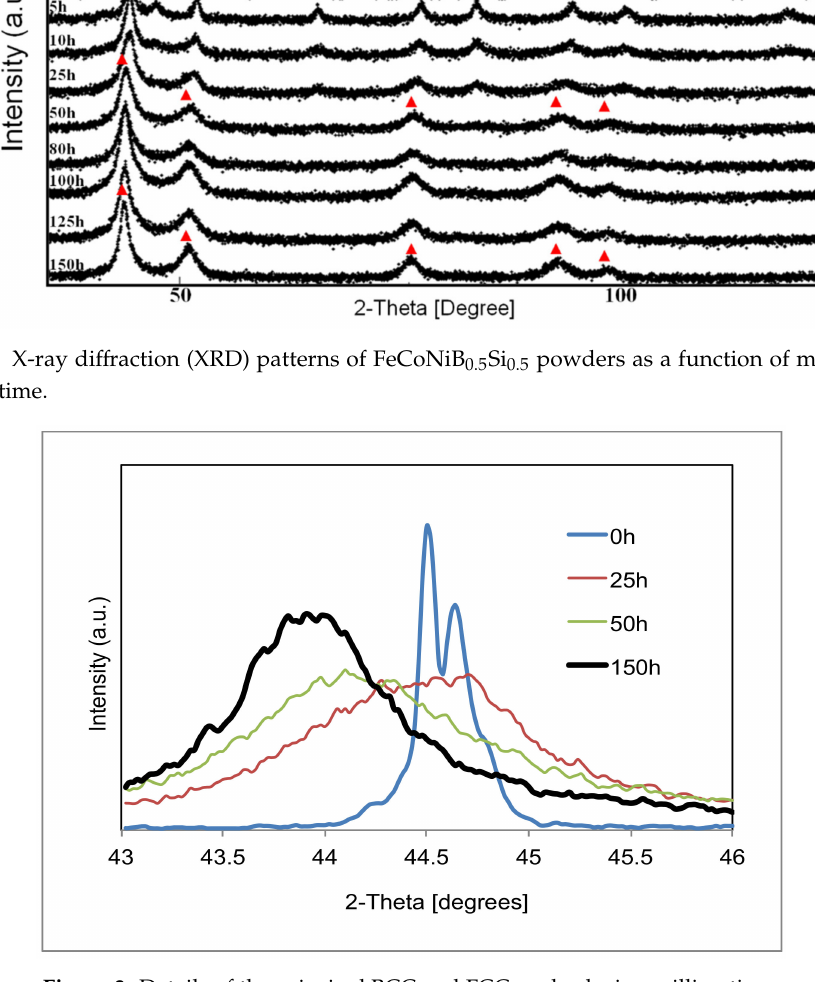
Figure 3. Details of the principal BCC and FCC peaks during milling